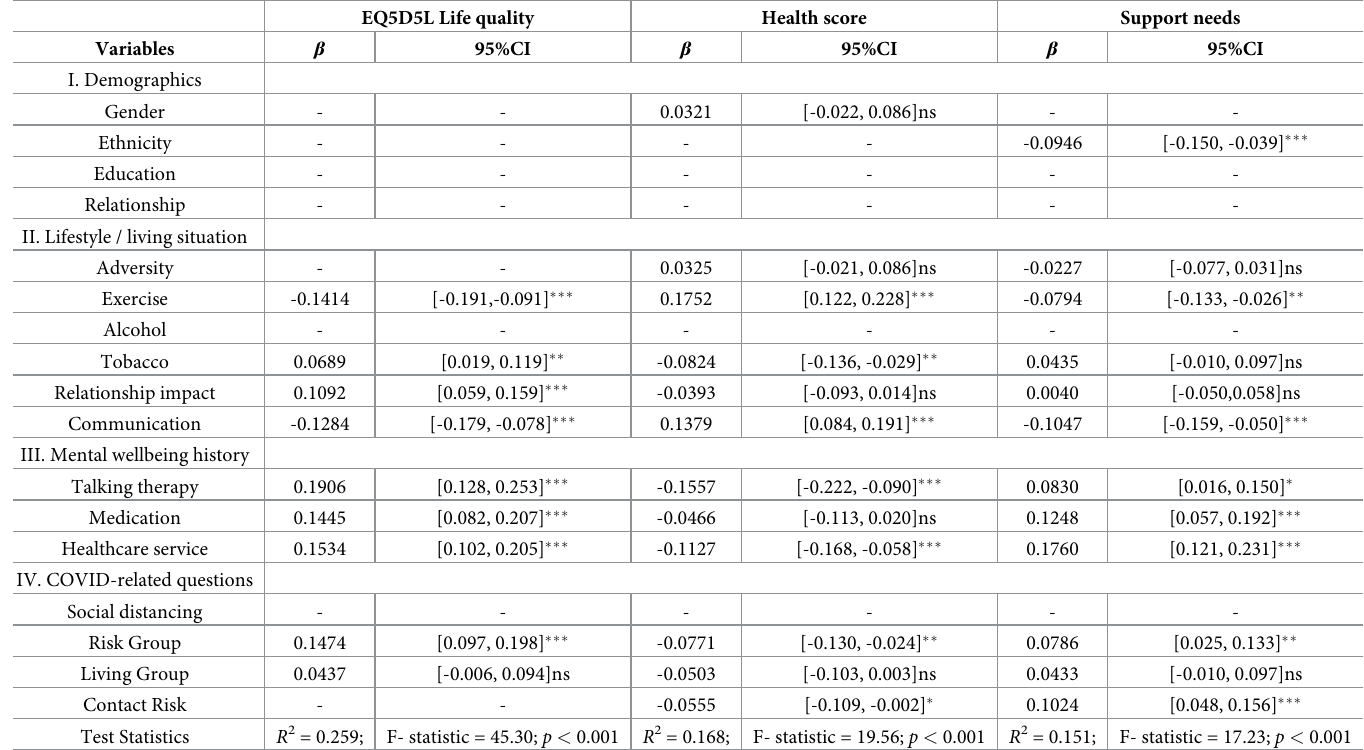
Table 14. Regression analysis (cont’d), where ns = non- significant( p > 0.05), � ( p � 0.05); �� ( p � 0.01); ��� ( p �